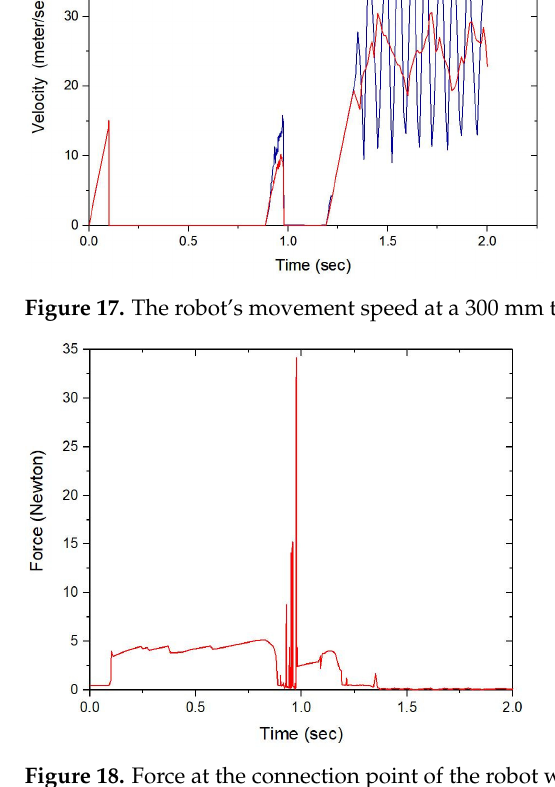
Figure 18 . Force at the connection point of the robot with a turning radius of 300